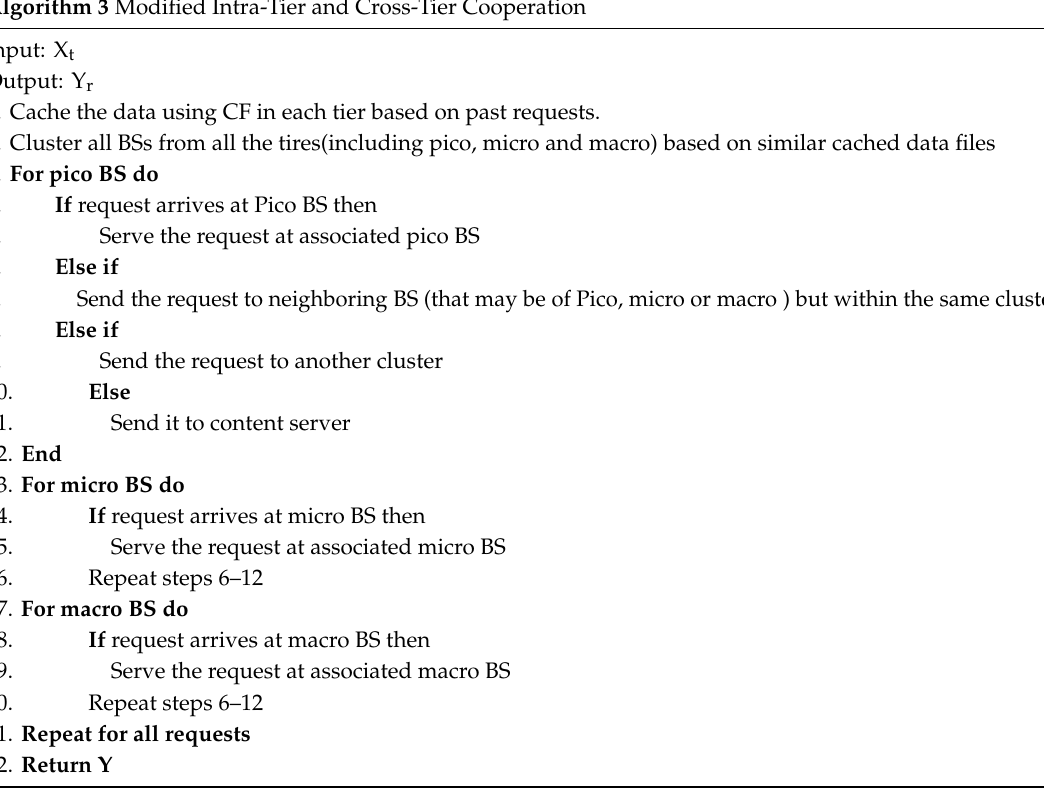
Figure 2. Cluster formation considering all tiers. Algorithm 3 Modified Intra-Tier and Cross-Tier